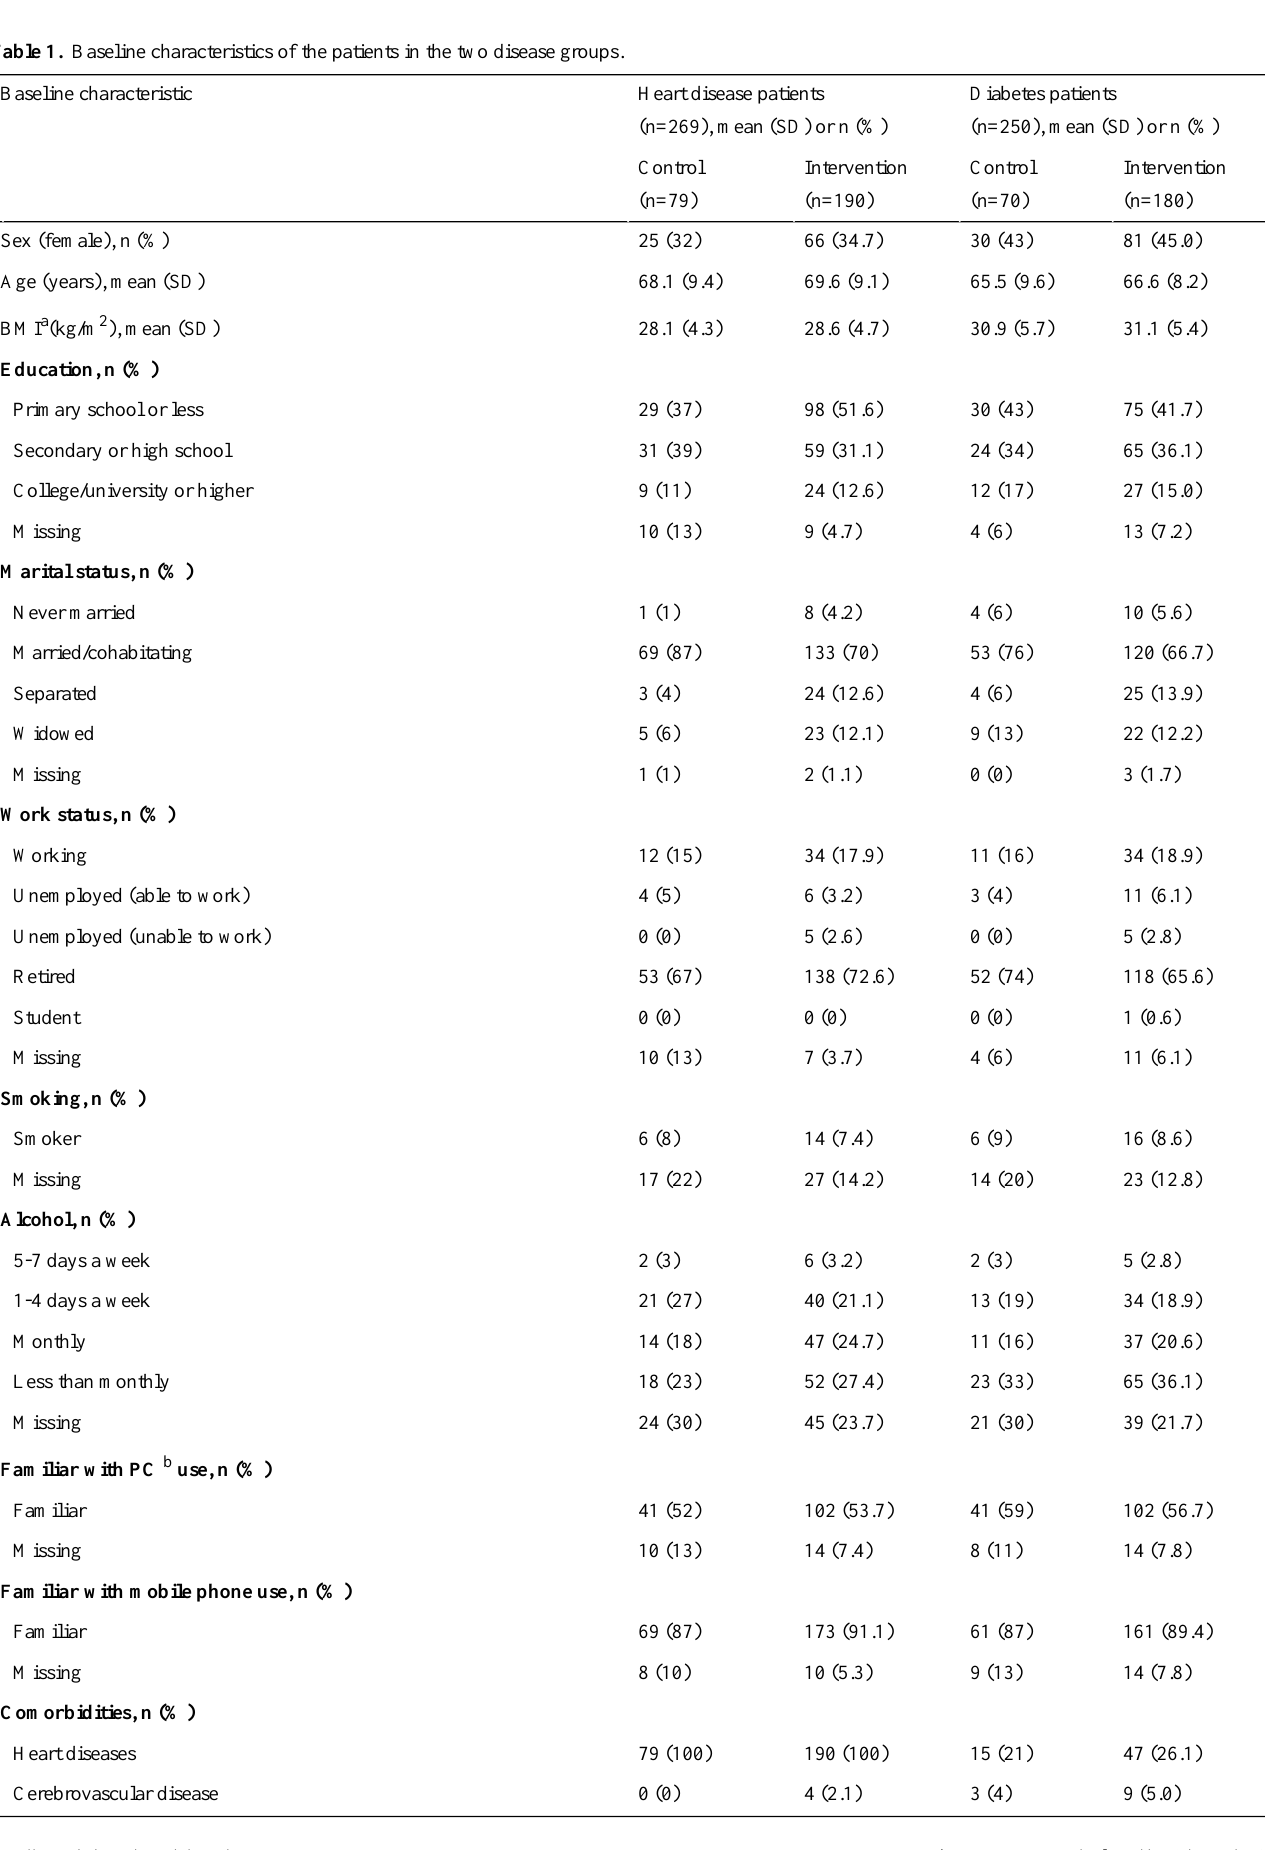
Table 1. Baseline characteristics of the patients in the two disease groups.